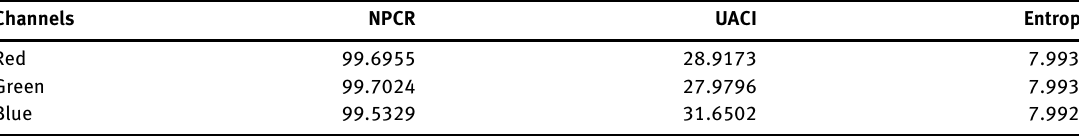
Table 2: NPCR, UACI, and Entropy Values of Encrypted R, G, and B Channels.